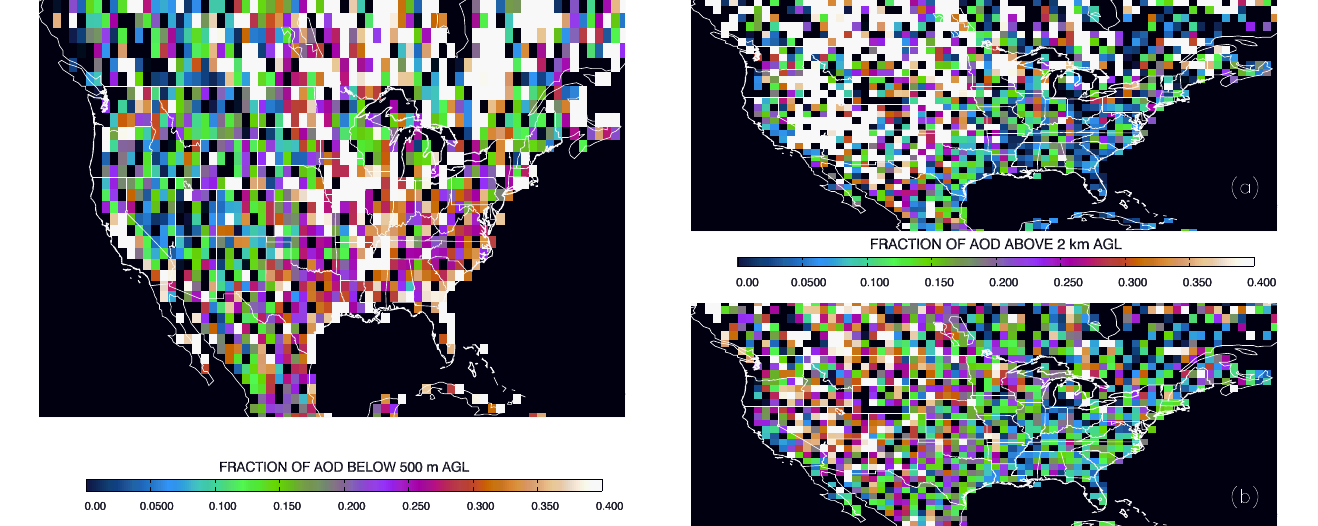
Figure 7. Two-year (2008–2009) 1 ◦ × 1 ◦ average contribution per- centage of 0–500m a.g.l. integrated CALIOP extinction to total column AOD (at 0.532µm) relative to the number of cloud-free CALIOP profiles in each 1 ◦ × 1 ◦ bin, for the contiguous United States.